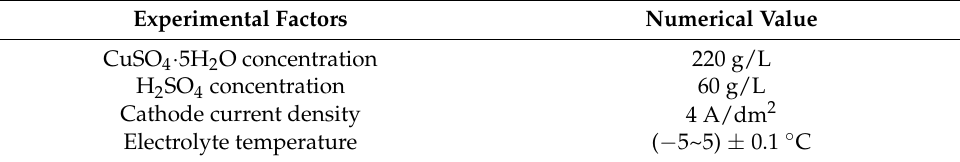
Figure 1. Schematic diagram of the experimental device and experimental reaction. There is a refrigerant circulating around the electrolyte. After the cathode and anode are powered the copper atoms on the anode lose electrons and become copper ions. The copper ions near the cathode are deposited on the cathode substrate. Table 1. Experimental